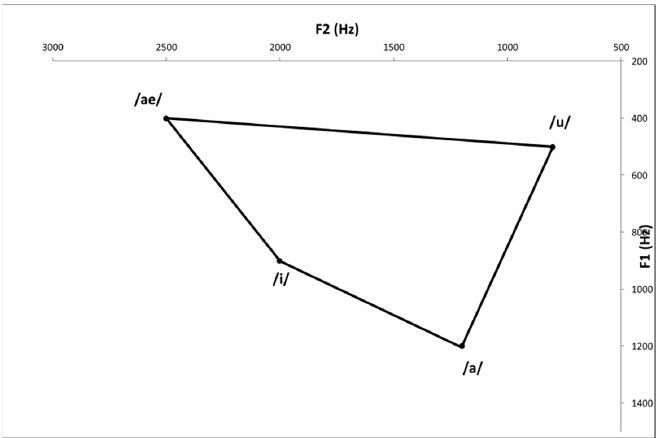
Figure 1. Normal acoustic vowel space.